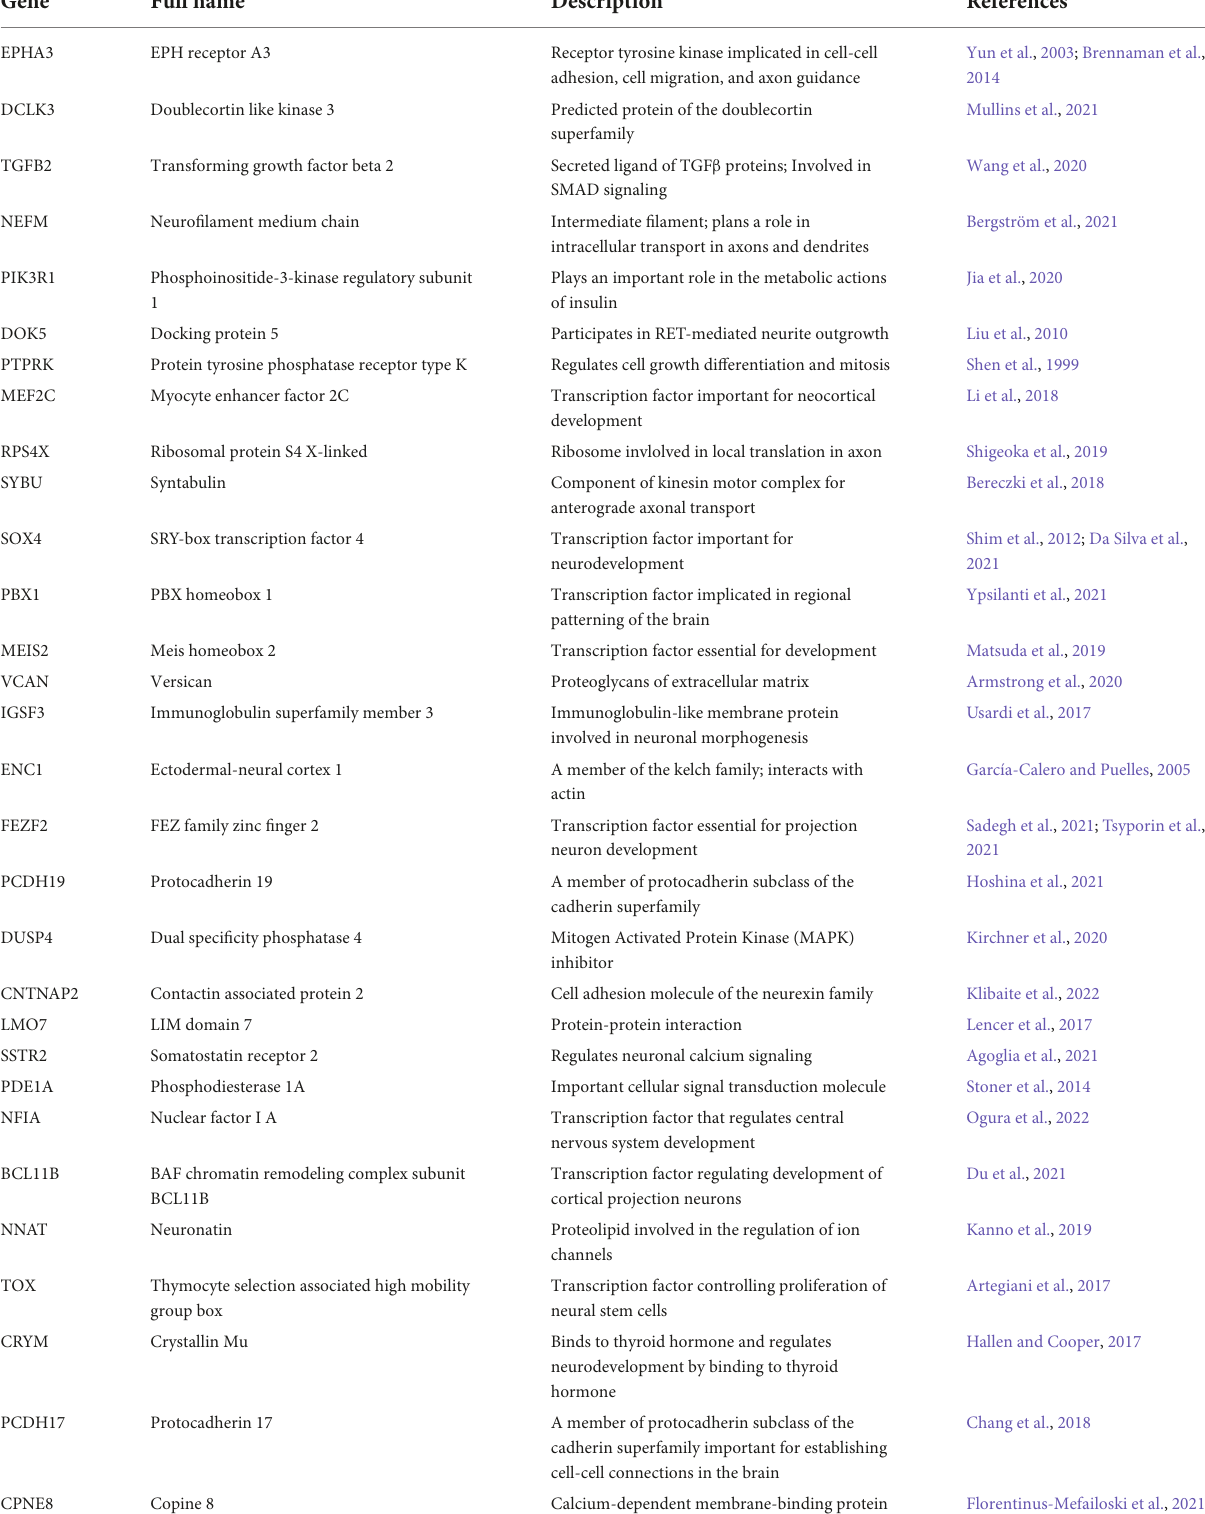
TABLE 1 Genes from the principal graph analysis of ExN4 that are associated or unassociated with the trisomic